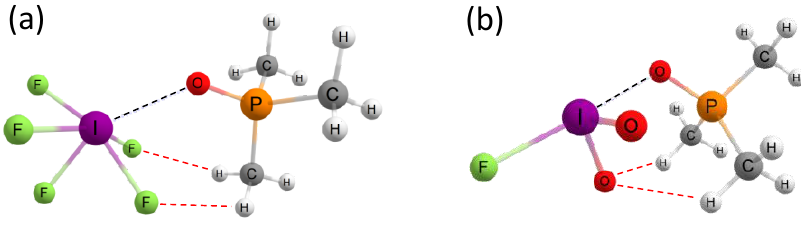
Figure 5. Examples of additional non-covalent interactions (red dashed lines) present in some halogen-bonded (black dashed line) R–X · · · OPMe 3 complexes: hydrogen bonds between methyl protons of the Me 3 PO moiety and electronegative atoms of the halogen donor; ( a ) two H-bonds with two proton acceptors; ( b ) two H-bonds with one proton acceptor; ( c ) two H-bonds with the halogen donating